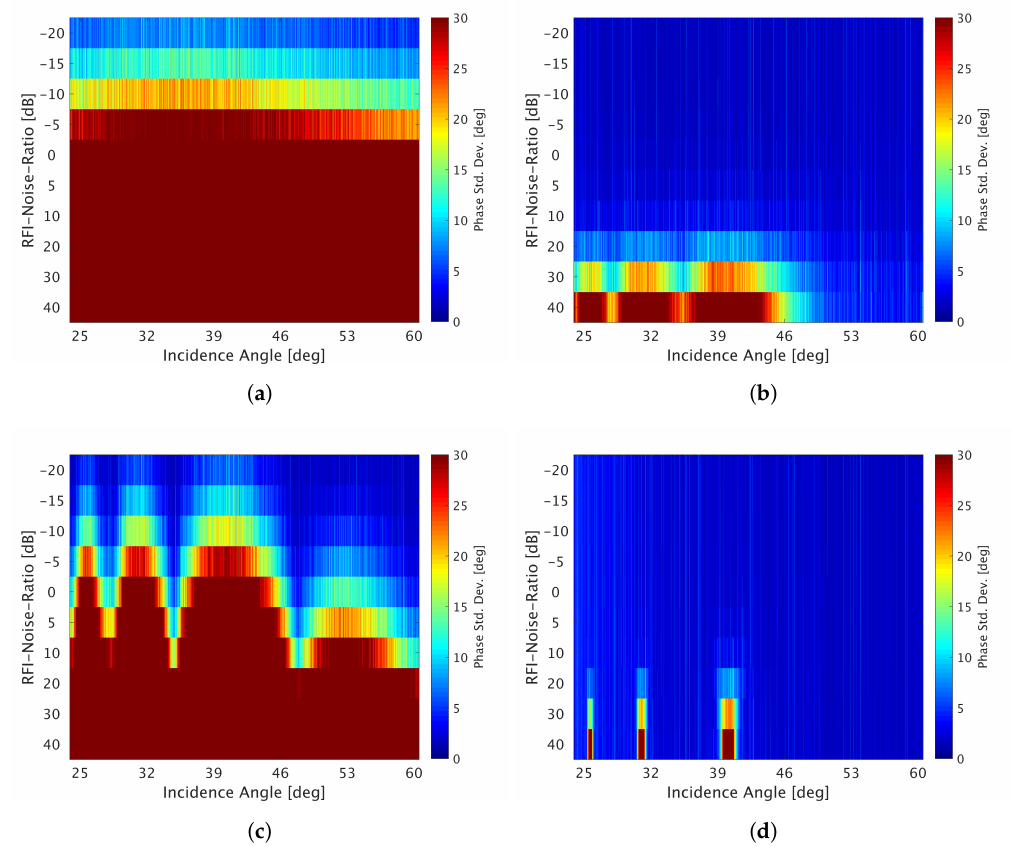
Figure 31. The phase standard deviation of the residual error image of scenario D for different RFI-Noise-Ratios versus the incidence angle of the instantaneous SAR signal. The SNR is 37.36 dB. ( a ) No RFI mitigation for N = 8, ( b ) After RD-Frequency MVDR beamforming for N = 8, ( c ) No RFI mitigation for N = 32, ( d ) After RD-Frequency MVDR beamforming for N =